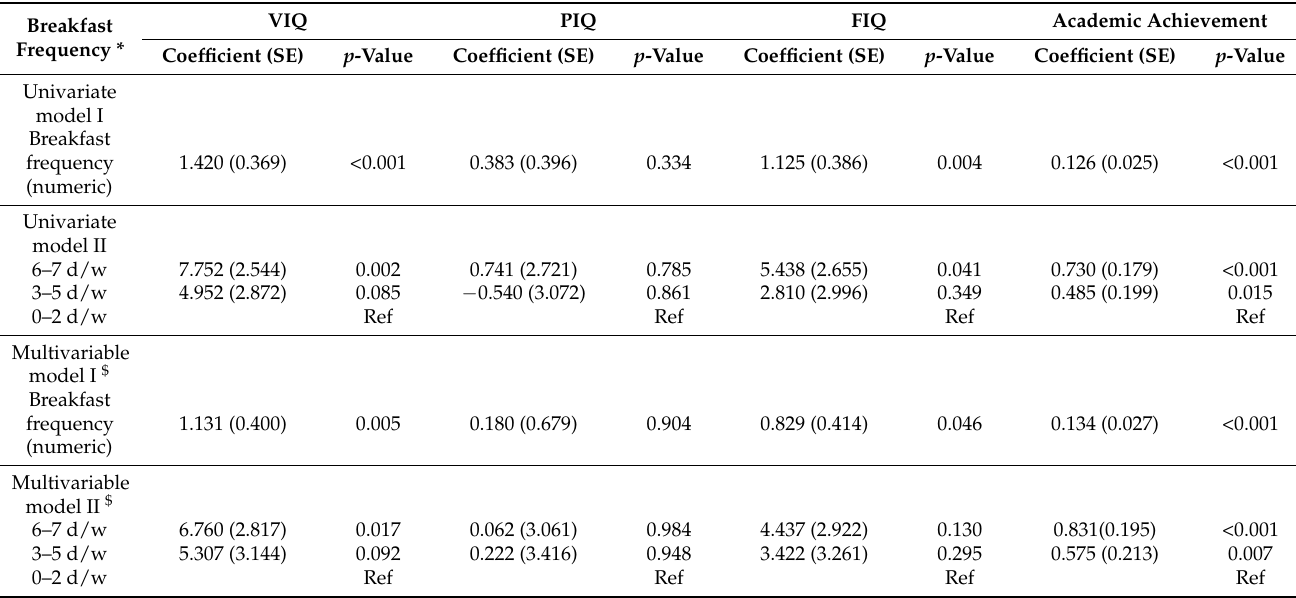
Table 4. Dose-response relationship between breakfast consumption frequency and IQ scores/academic achievement of the 2nd wave ( n =